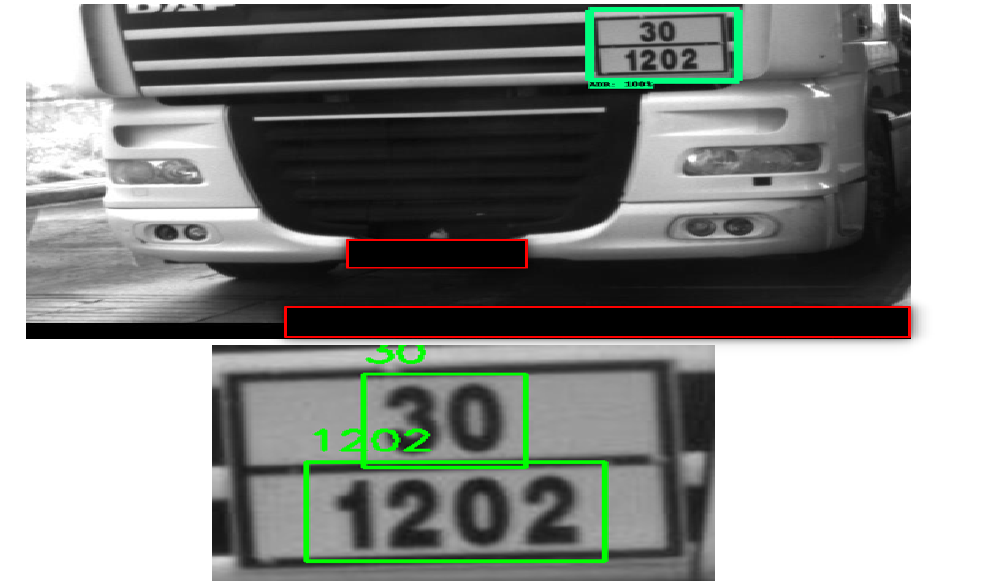
Figure 4. HMRT-EF OCR process with its OCR preview capabilities enabled displaying the detected Regions of Interest.